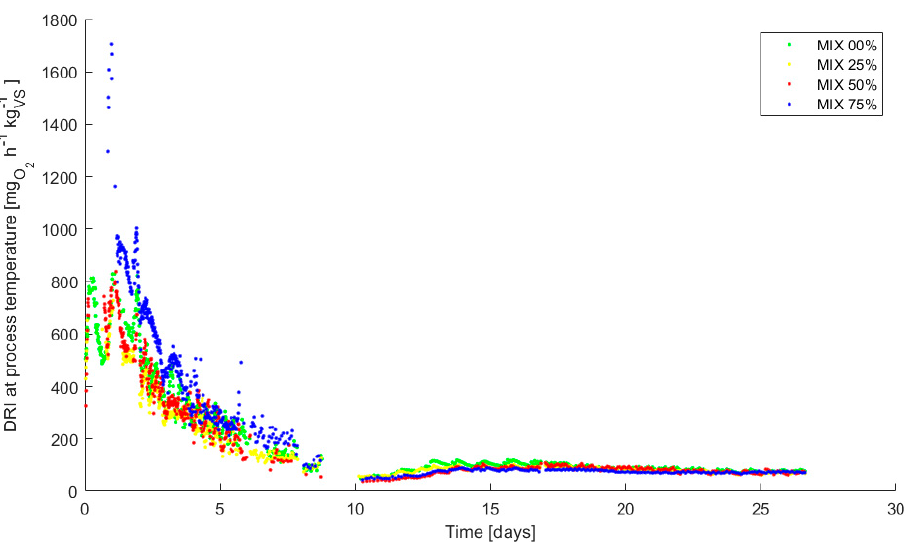
Figure 8. Online measurements of Dynamic Respirometric Index (DRI) (expressed in mg O 2 kg VS − 1 h − 1 ) during composting.